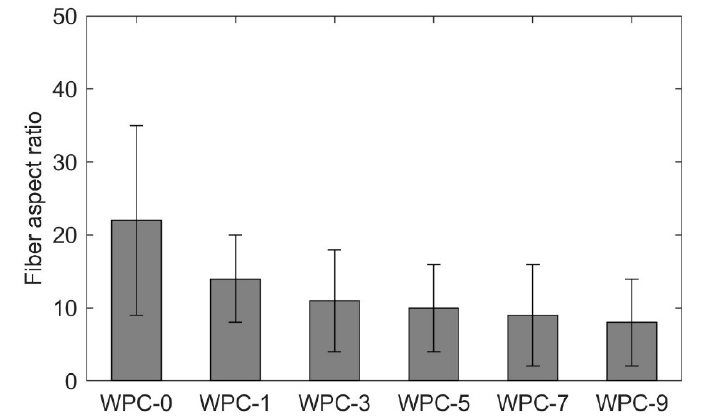
Figure 3. Fiber aspect ratio (compacted-TMP extracted from WPCs using Soxhlet).